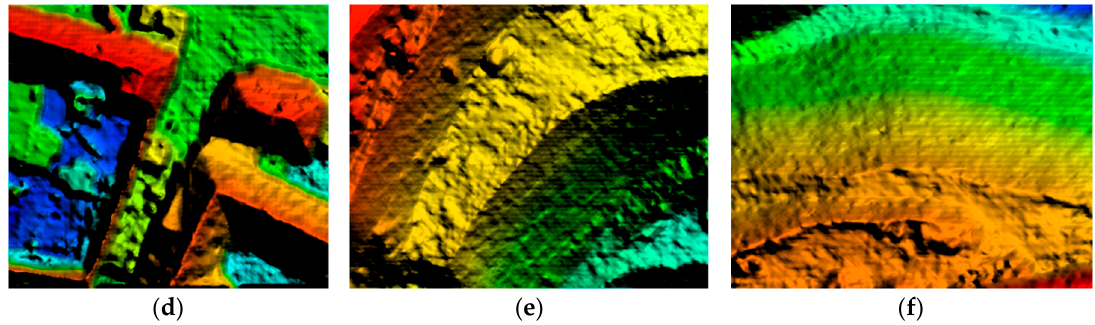
Figure 14. Results at slanted planes: ( a – c ) DSMs generated by standard semi-global aggregation; and ( d – f ) DSMs generated by the proposed improved semi-global aggregation.